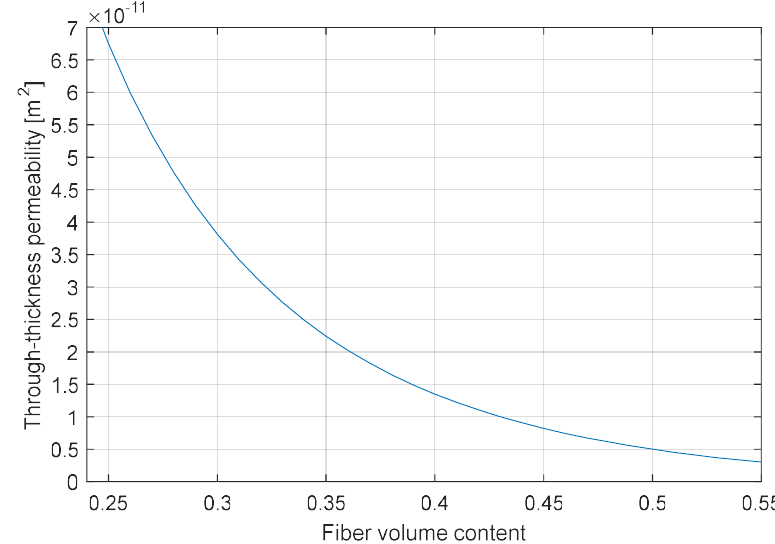
Figure 11. Through-thickness permeability ( K 3 ) curve for the C-RTM process simulations for the second hood geometry. Table 6. Fill times and injectability numbers for filling cases of the second hood geometry.